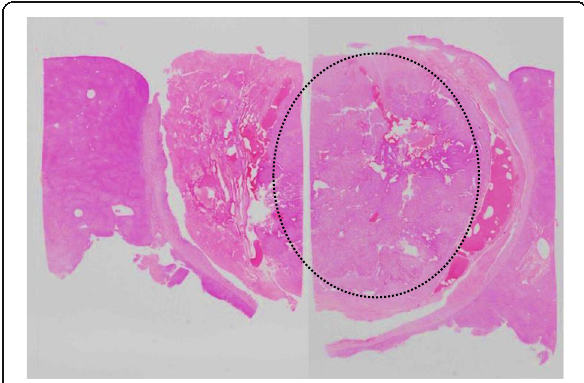
remained inside of dashed